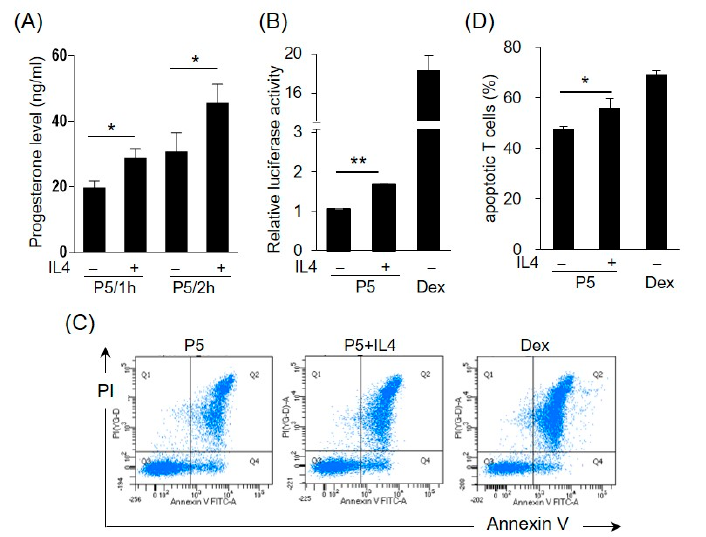
Figure 6. IL4 induces 3 β -HSD activity and bioactive glucocorticoid (GC) production in HT-29 cells. ( A ) The HT-29 cells were treated with IL4 (20 ng/mL) or a vehicle for 12 h and the medium was replaced with a fresh medium containing pregnenolone (P5). After 1 or 2 h, the progesterone levels in the culture medium were measured. The values are represented as the means ± SEM of three independent experiments; * p < 0.05. ( B – D ) Conditioned media (CM) were prepared from the HT-29 cells treated with IL4 (20 ng/mL) or a vehicle with P5 for 24 h. Dexamethasone (10 nM in ( B ), 1 nM in ( D )) was used as the positive control. ( B ) The pGRE-tk-Luc reporter construct was co-transfected into HEK293T cells with the expression vector for the GC receptor (GR). After 24 h, the cells were cultured in the HT-29-derived CM. The cells were harvested after 24 h and assayed for luciferase activity. The values are represented as the means ± SEM of three independent experiments; ** p < 0.01. ( C ) Murine splenocytes were isolated and cultured in the HT-29-derived CM. The murine splenic T cells were detected using an APC-conjugated anti-mouse CD 3e antibody. Apoptotic T cells were detected using annexin V and propidium iodide (PI). The apoptotic cells were analyzed by flow cytometry. ( D ) Statistical analysis of the apoptotic T cells. The values are represented as the means ± SEM of four independent experiments; * p < 0.05 via one-way ANOVA.